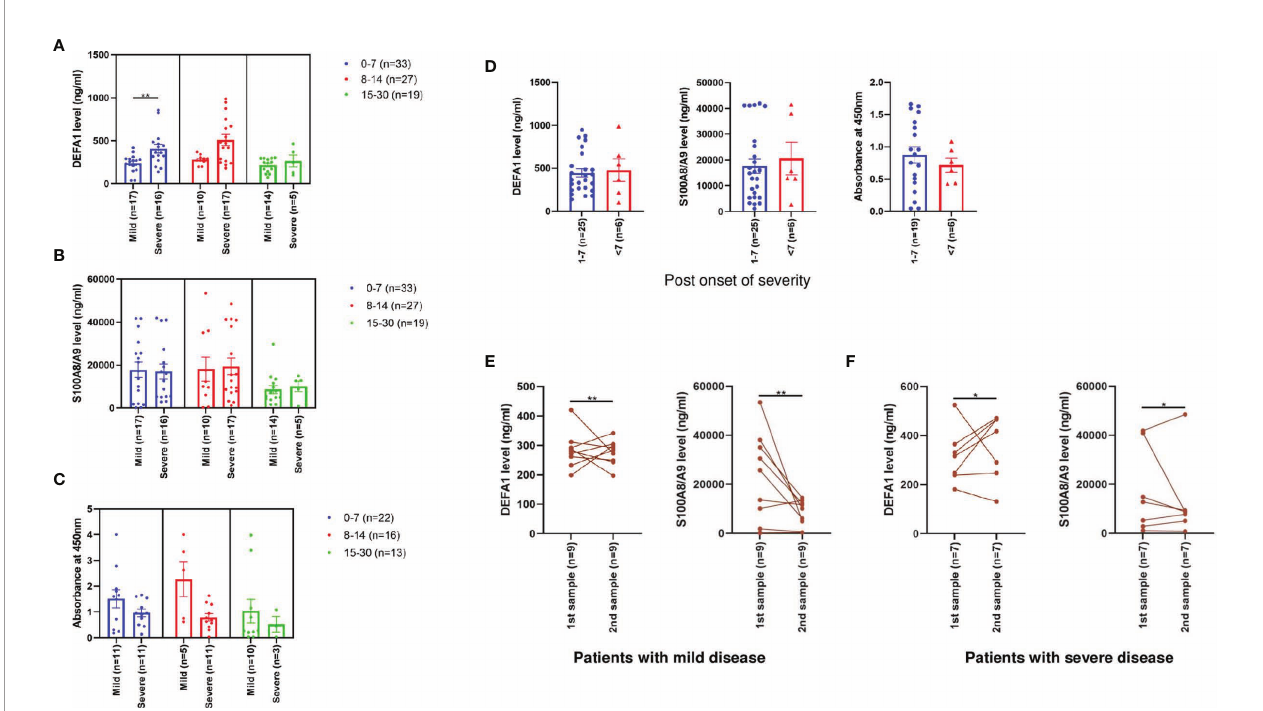
FIGURE 2 | Expression levels of neutrophil activated proteins in sera/plasma of mild and severe COVID-19 patients. Figures A-C depict comparisons of levels of (A) DEFA1, (B) S100A8/A9 and (C) MPO among mild and severe disease patients at different PODs. Comparative levels of (D) DEFA1, S100A8/A9 and MPO among severe disease patients at different days post onset of severity. The data is presented as dot plots with bar representing the mean ± SEM in each group. Each dot represents a single sample. P values were calculated using Mann-Whitney test. ** denotes p-value < 0.01. (E) Expression levels of DEFA1 and S100A8/A9 levels in SARS-CoV-2 patients with mild disease at the time of admission (POD 2-14) and at follow-up (POD 8-21). (F) Expression levels of DEFA1 and S100A8/A9 levels in SARS-CoV-2 patients with severe disease at the time of admission (POD 5-14) and at follow-up (POD 7-19).The data are presented as line graphs with each line representing a single individual. P values were calculated using the Wilcoxon signed rank test. * denotes p-value < 0.05, ** denotes p-value <